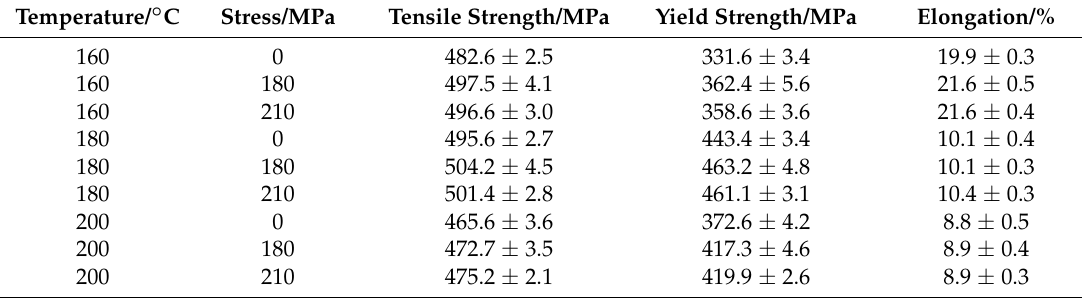
Table 3. Mechanical properties of the alloy after creep